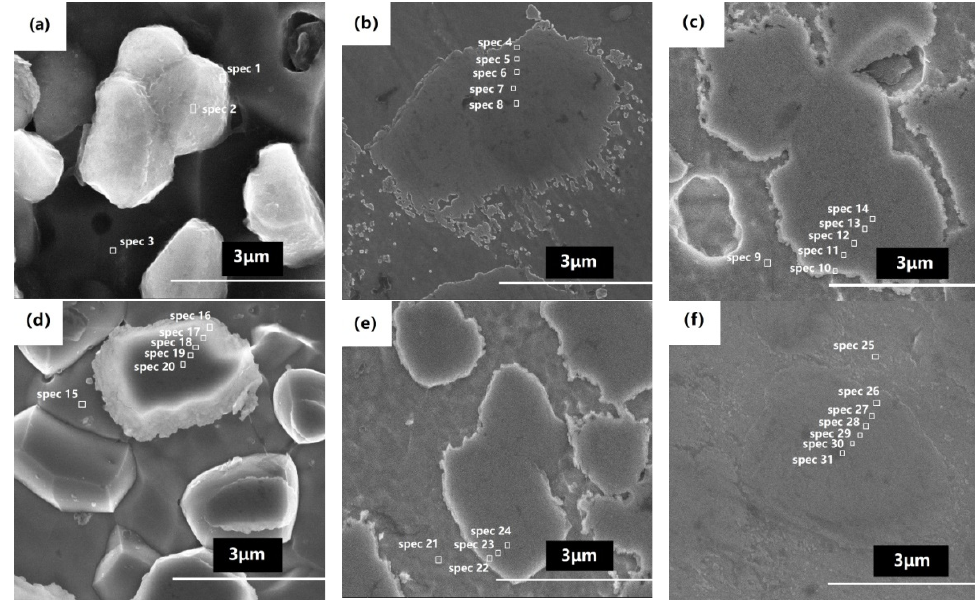
Figure 3. Microstructure and SEM-EDS point analysis of BSSs after heat treatment at (a) 900 °C, (b) 1000 °C, (c) 1050 °C, (d) 1100 °C, (e) 1150 °C and (f) 1200 °C.